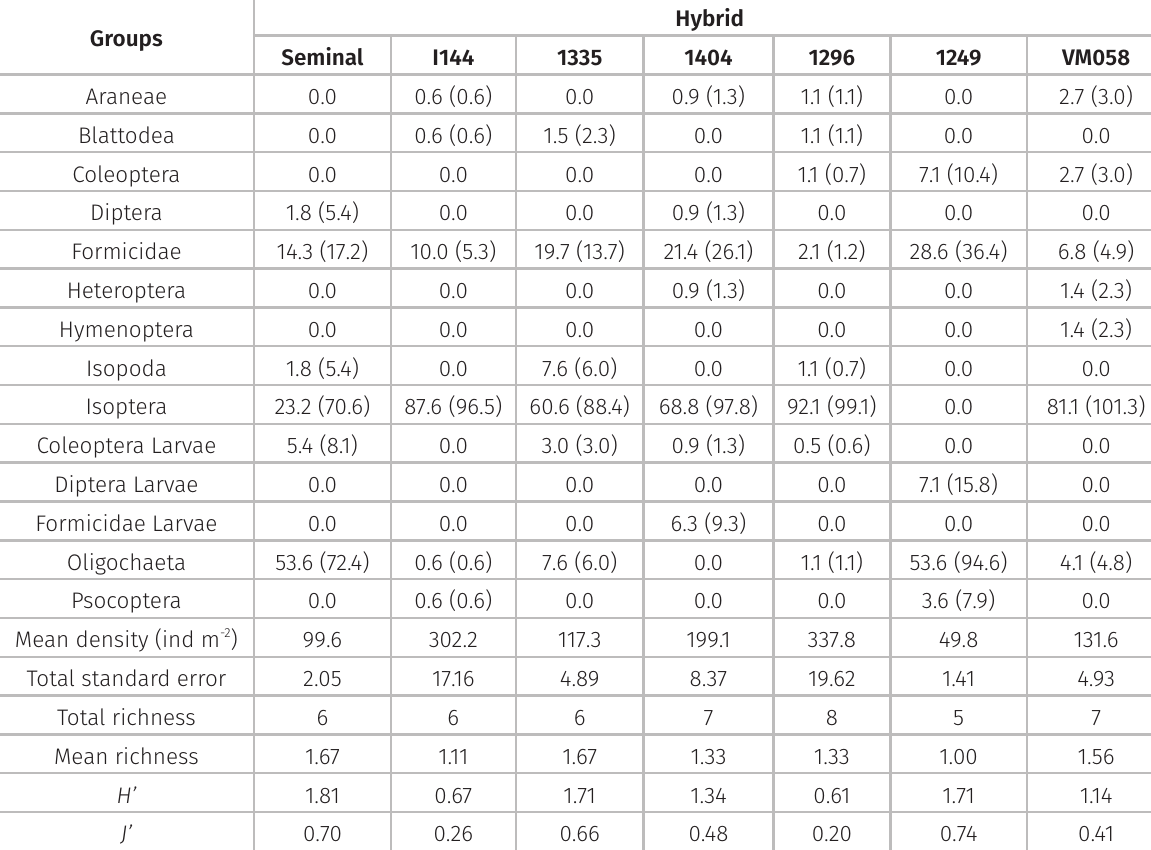
Table IV. Relative density (%) of the large taxonomic groups, standard deviation (in parentheses), density, standard error, total and average richness, and Shannon and Pielou indices of the soil macrofauna under Eucalyptus hybrids in Vitória da Conquista,